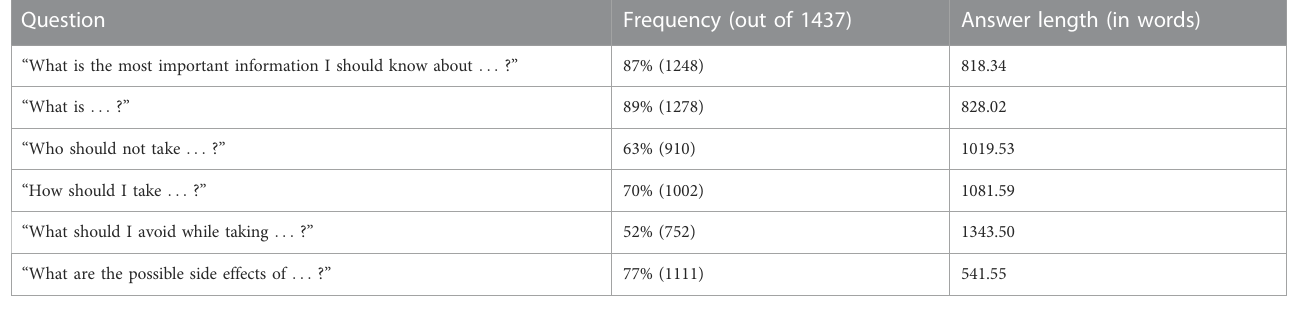
TABLE 1 Frequency of guiding questions in the dataset.